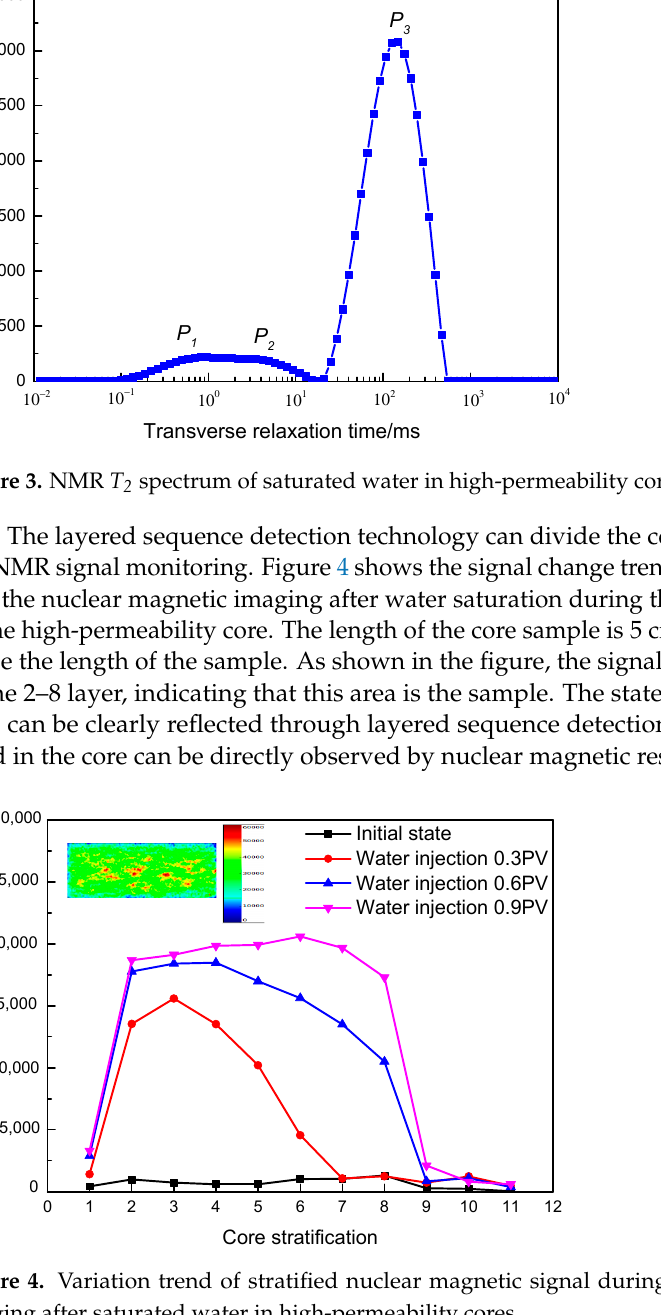
the total signal value of 1 H proton fluid contained in the core pores, and the larger the peak area, the more 1 H proton fluid is contained in the core pores. Conversely, less 1 H proton fluid is contained in the pores [18,19]. Figure 3 shows the NMR T 2 spectrum curve of the core saturated with water. The area under the left peak ( P 1 peak) represents the Figure 3. NMR T 2 spectrum of saturated water in high-permeability core. total signal value of the liquid in the small pores. The area of the middle peak ( P 2 peak) represents the total signal of the liquid in the mesopores. The area of the right peak ( P 3 peak) represents the total signal value of the liquid in the large pores. Therefore, during the core displacement experiment, by measuring the change in the transverse relaxation curve ( T 2 spectrum) of the 1 H-containing proton fluid in the core, the distribution of the 1 H-containing fluid in different pores and the change in its content in the core can be obtained.